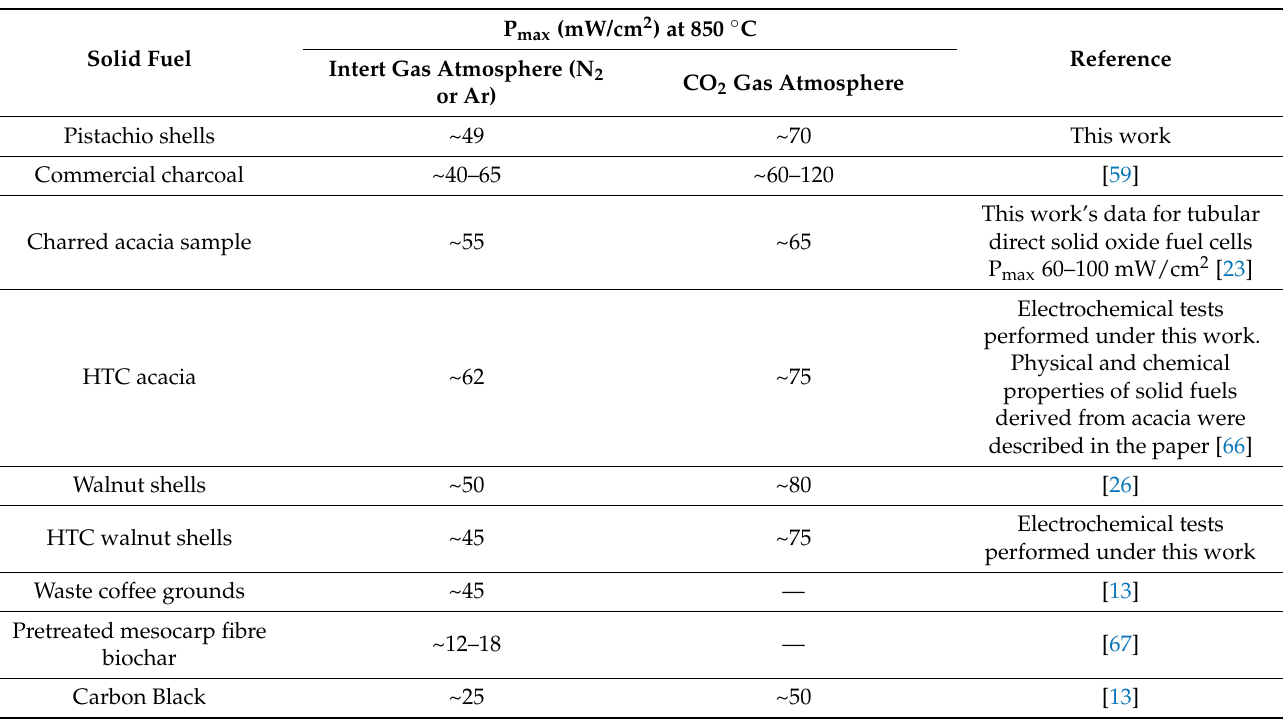
Table 3. Comparison of electrical performance of DC-SOFC (I) for different solid fuels.